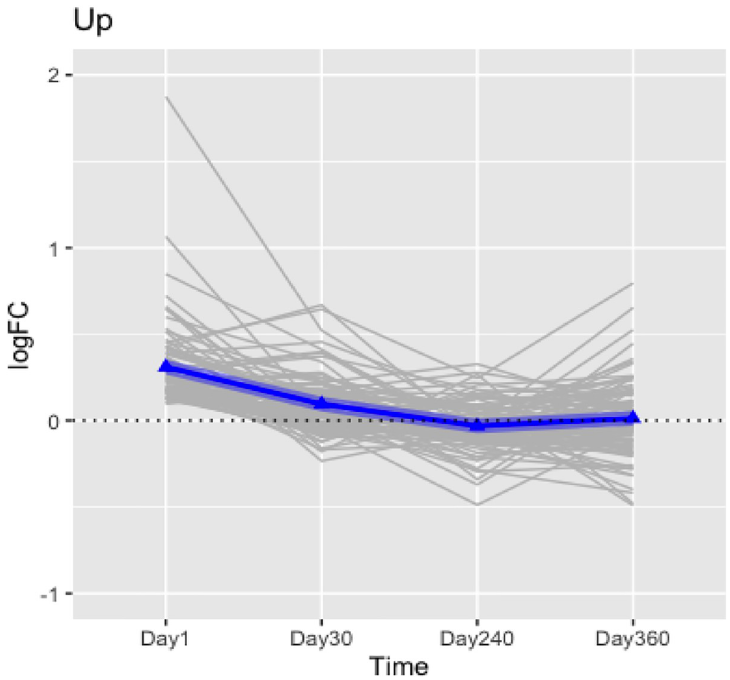
Fig 5. Trajectories of logFC of the DEG up-regulated with short-term effects (ISO vs. na ï ve rats). The trajectory plot was generated using the logFC value between the ISO and na ï ve rats vs each post-exposure timepoint for each up- regulated gene. The 87 DEG (either up-regulated with p-value < 0.05 on Day 1 or consistently up-regulated with p- value < 0.1 at Days 1 and 30) were associated with wound healing and circadian rhythm pathways. The trajectories of the logFC for each gene were plotted as gray lines. The blue lines connecting the blue triangles are the mean trajectory. Groups of rats exposed to air (na ï ve, n = 6/each timepoint group) or ISO (n = 5/Day 1 group, and n = 6/Day 30, 240, and 360 group) were